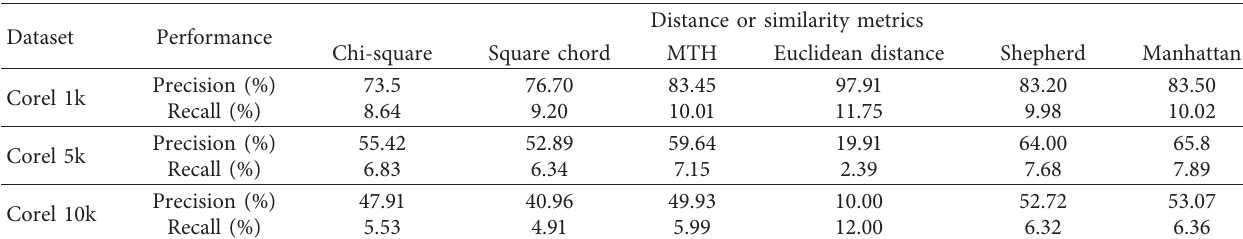
Table 5: Average retrieval precision and average retrieval recall of NRLGO by varying combinations of gradient orientation and color quantization levels by keeping contrast information fixed at 5 on Corel 5k in